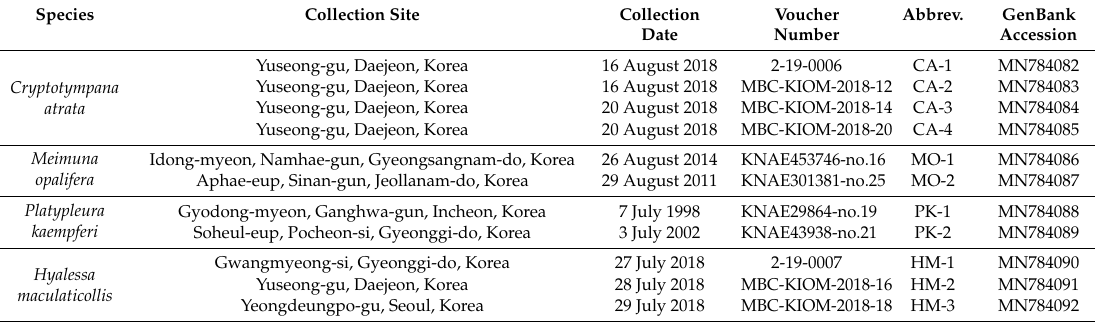
Table 1. Sources of cicada species used for sequence analyses and marker